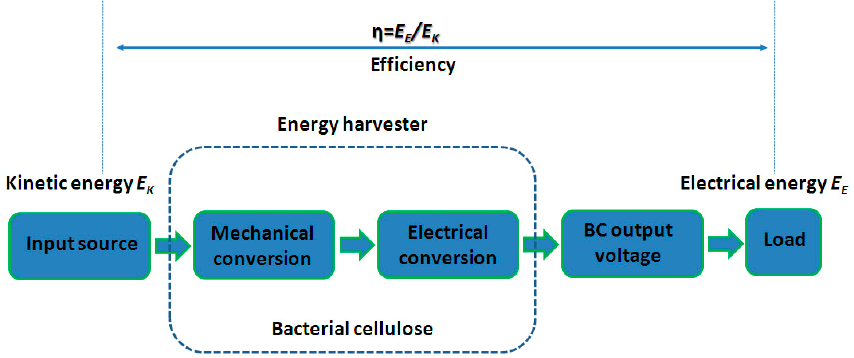
Figure 11. Block diagram of the green energy harvester architecture.